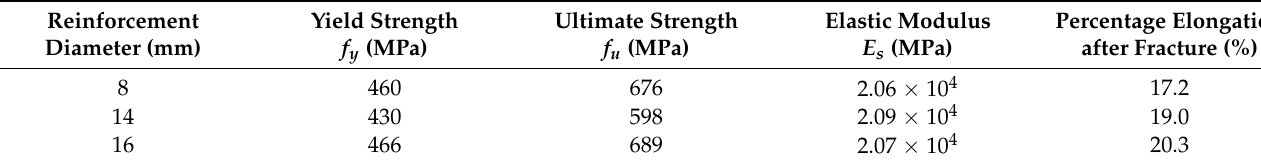
Figure 6. Stress–strain curve of rebars. Table 7. Mechanical behaviour of rebars.